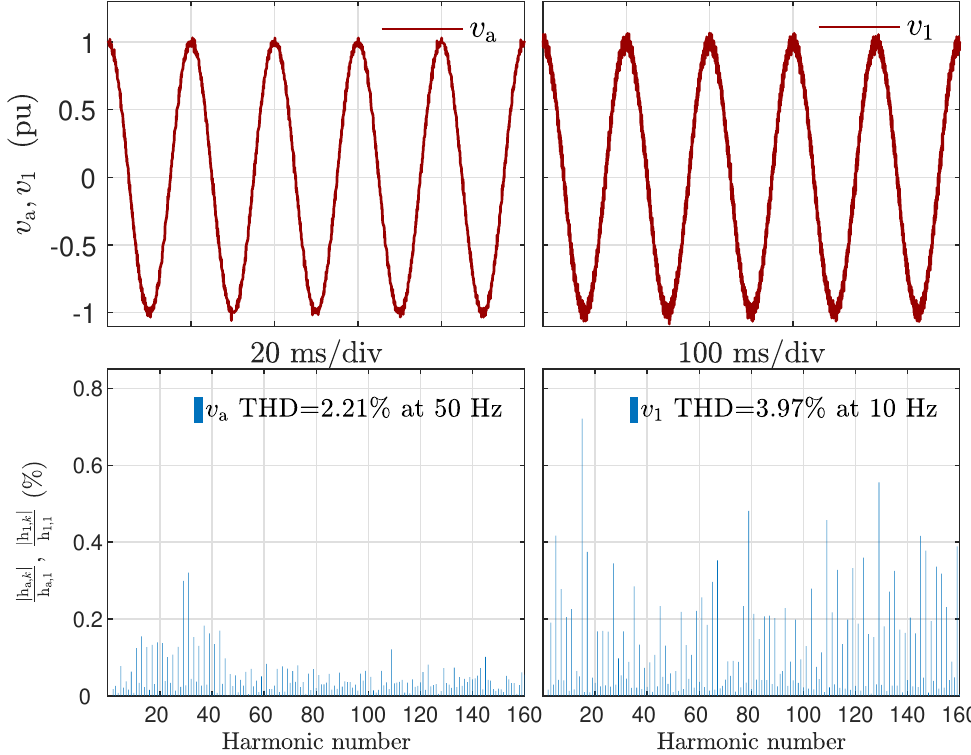
Figure 21. Spectrum of v a , v 1 and THD calculations, when NLC modulation technique is